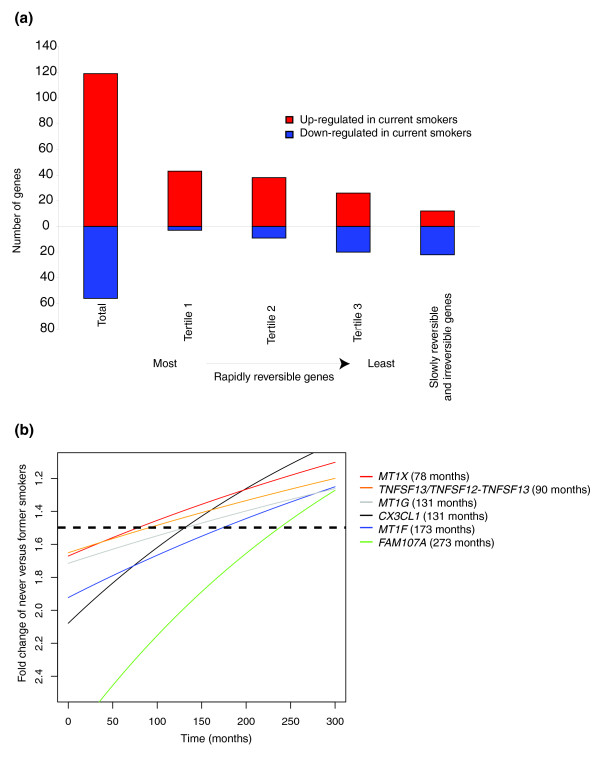
Characteristics of genes classified as irreversible, slowly reversible, or rapidly reversible based on their behavior in former smokers. (a) Numbers of genes up-regulated (red) or down-regulated (blue) in current smokers compared to never smokers. The percentage of genes up-regulated in smoking decreases from the most to the least reversible tertile of rapidly reversible genes and is lowest in the slowly reversible and irreversible genes. (b) The age-adjusted fold change between never versus former smokers (y-axis) is plotted as a function of time since quitting smoking (x-axis) for the genes classified as slowly reversible. All the slowly reversible genes are down-regulated in smoking. The time point that the fold change equals 1.5 (see dotted line) is defined as the time that the genes become reversible. The time point at which this occurs is greater than 78 months (6.5 years) after smoking cessation for all of the slowly reversible genes.